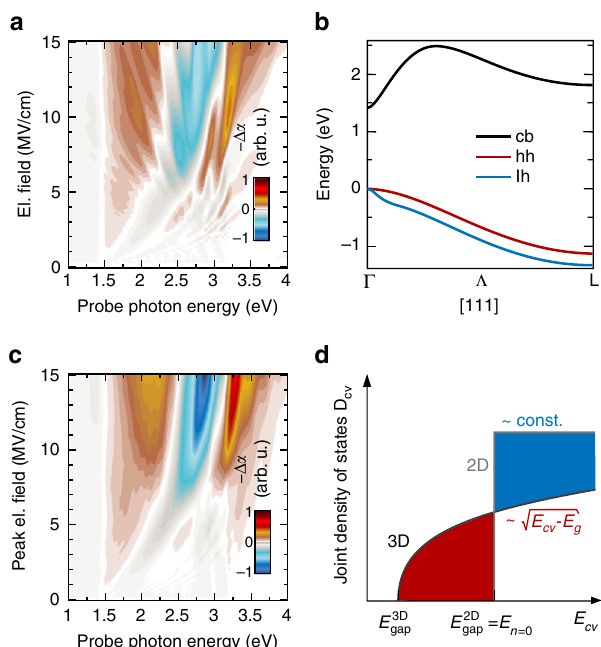
Fig. 4 Simulations with realistic band dispersions. a Negative absorption change − Δα with respect to the unbiased case color-coded versus photon energy and stationary electric fi elds, as obtained adopting the GaAs light- hole (lh, blue), heavy-hole (hh, red) and conduction band (cb, black) dispersions along the Λ -direction in b . Details are explained in Methods. c Negative absorption change - Δα color-coded versus photon energy, as expected when probing in the fi eld maximum of an oscillatory bias of 25 THz frequency. d Visualization of the change in joint density of states D cv as a function of relative energy E cv between valence and conduction bands. Omitting excitonic effects, D cv ( E cv ) is proportional to the absorption constant α cv ( E cv ). In case of a three-dimensional semiconductor with parabolic bands, D cv increases square-root-like starting at the bandgap energy E gap 3D . As wave functions become localized in one direction, D cv changes to the step-function-like behavior characteristic for two- dimensional electronic systems. A larger bandgap energy E gap 2D results, corresponding to the transition energy E n = 0 of the central step in the Wannier – Stark ladder (see Fig. 3d). When measuring the differential transmission change between both scenarios, a characteristic bleaching region (shaded in red) occurs below and induces absorption (blue) above